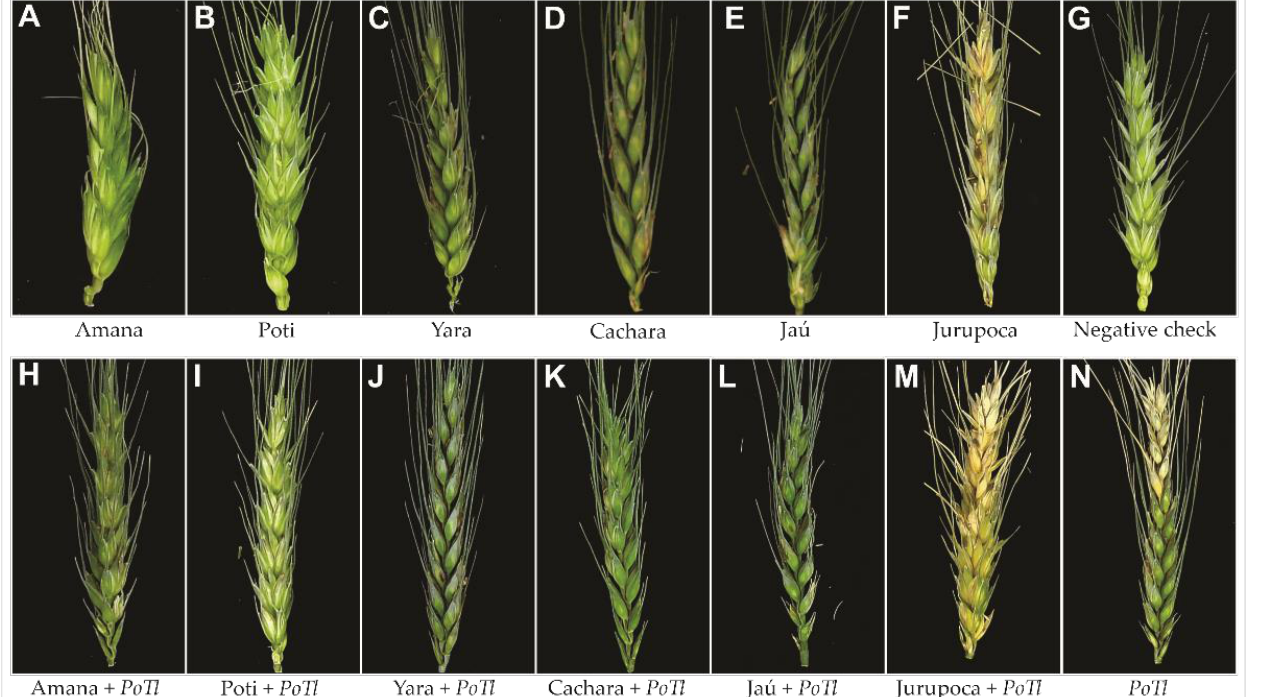
Figure 8. Heads of wheat cv. Sossego inoculated or not with Pyricularia oryzae Triticum lineage (PoTl) , and treated with bacterial and fungal antagonists, which included fluorescent Pseudomonas species (strains ‘Amana’, ‘Poti’ and ‘Yara’) ( A – C , H – J ) or Trichoderma species (strains ‘ Cachara ’ , ‘ Jaú ’ and ‘ Jurupoca ’ ) ( D – F , K – M ). ( G ): Negative check. ( N ): Positive check inoculated only with PoTl . Bleached ears depicted in M and N had partial or total sterile spikelets from the infection point in the rachis with empty grains.